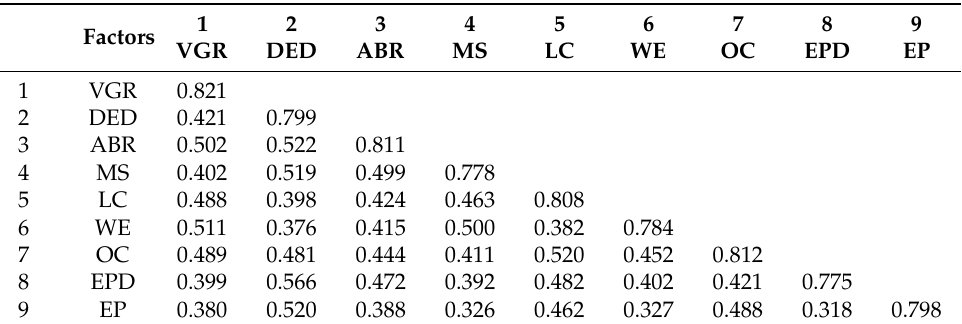
Table 3. Discriminant validity.